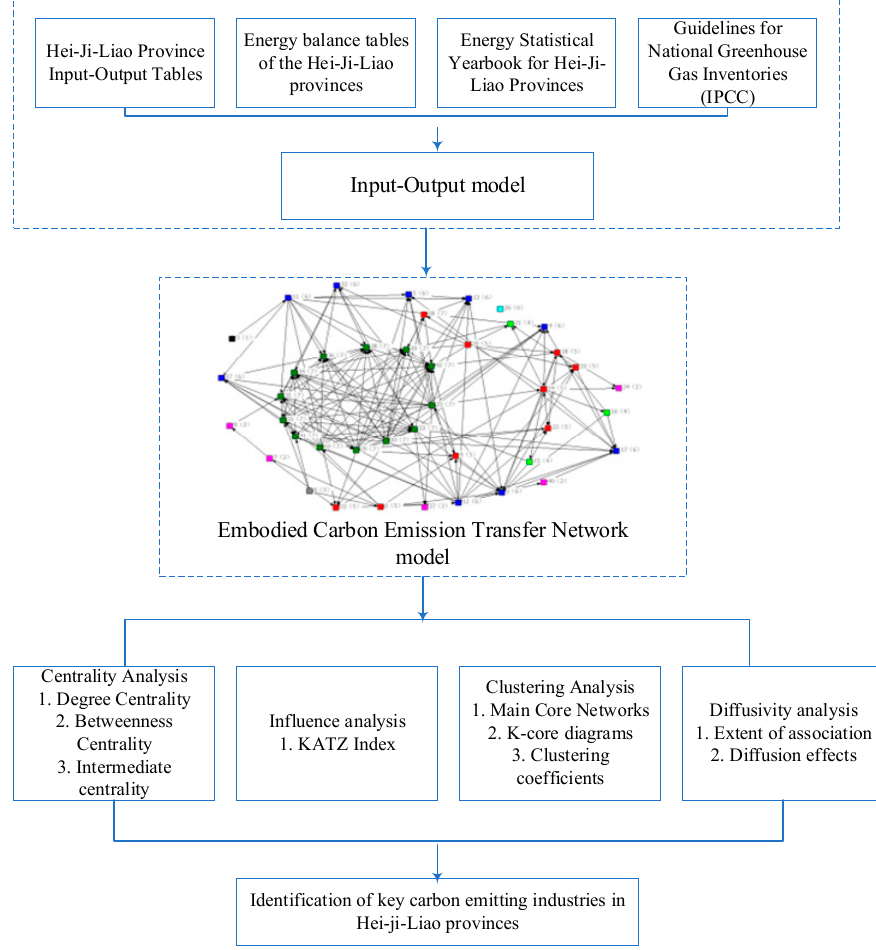
Figure 2. Technical framework and model selection for research.